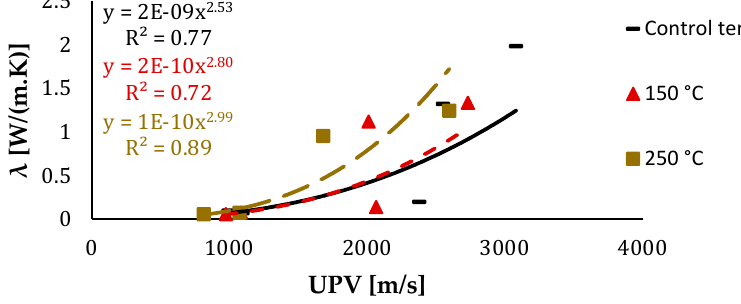
Figure 14. Relationship between ultrasound pulse velocity and thermal conductivity coefficient.